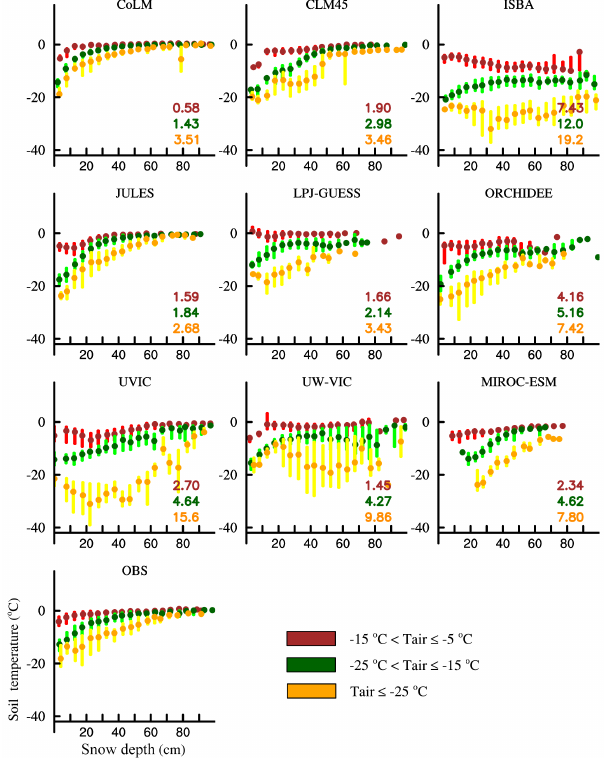
Figure 5. Variation of soil temperature at 20cm depth ( ◦ C; y axis) with snow depth (cm) for winter 1980–2000. The dots represent the medians of 5cm snow depth bins and the upper and lower bars indi- cate the 25th and 75th percentiles, calculated from all Russian sta- tion grid points ( n = 268) and 21 individual winters. The numbers in each model panel indicate the RMSE between the observed and modelled relationship. Colours represent different air temperature